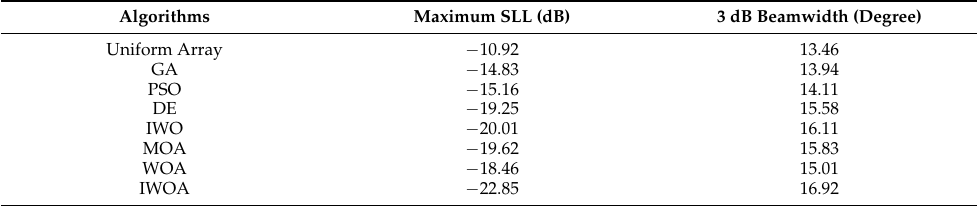
Table 6. The maximum SLL and beamwidth of the compared algorithms.